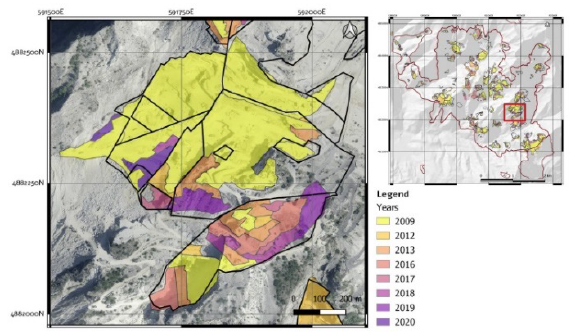
Figure 4 . Sample site with yearly detected changes areas (1:5000). Black outlines represent quarries’ own properties extents. Background: 2019